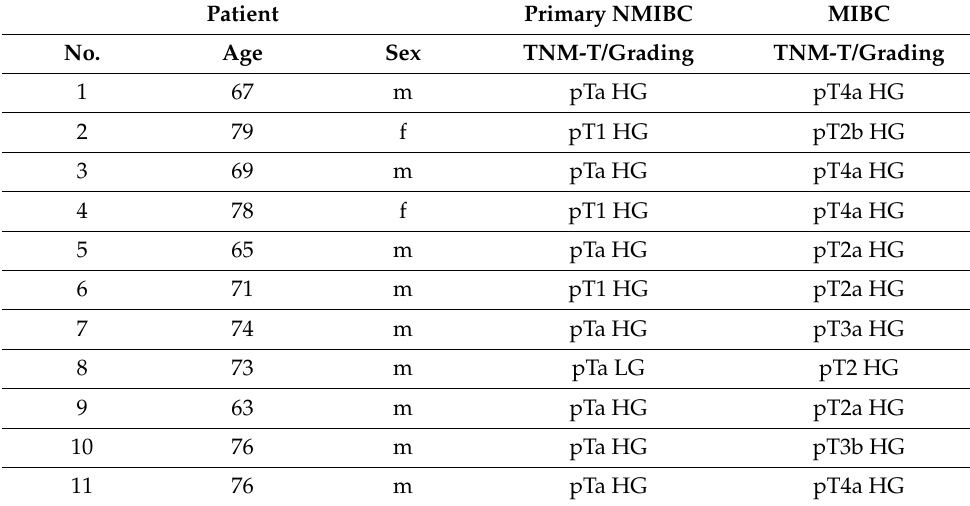
Table 1. Patient material and characteristics. NMIBC, non-muscle-invasive bladder cancer; MIBC, muscle invasive bladder cancer; LG, low grade; HG, high grade; m, male; f, female. Patient Primary NMIBC MIBC No. Age Sex TNM-T/Grading